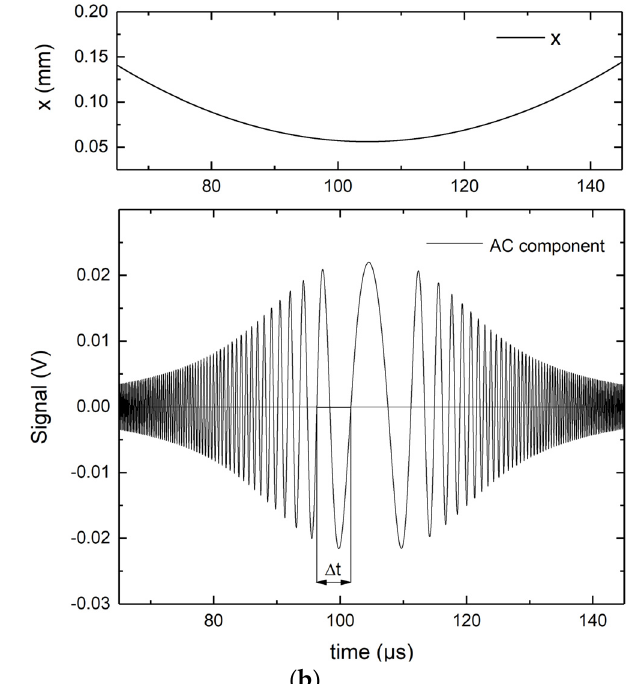
Figure 2. ( a ) Primary and secondary reflection of the laser source when the fiber tip is in close proximity to the bubble wall. ( b ) Top: the bubble wall distance from the fiber probe tip as a function of time that was used for the simulation model. Bottom: expected AC interferometric signal, treating the bubble as a flat mirror.